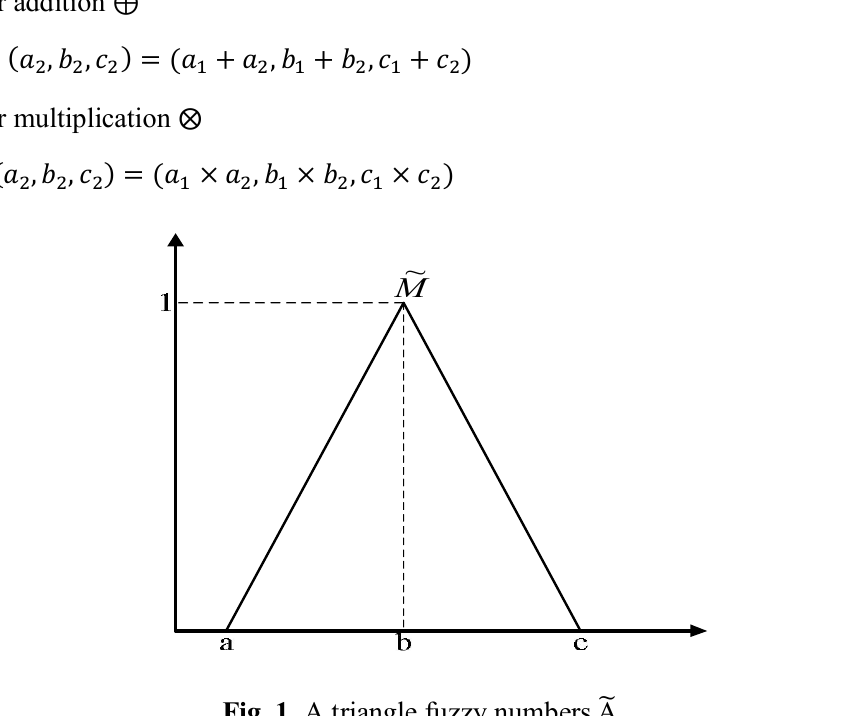
Fig. 1. A triangle fuzzy numbers A